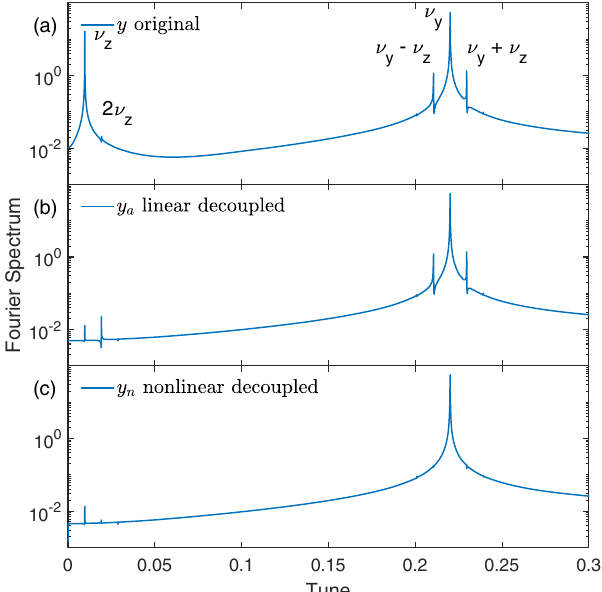
FIG. 2. Decoupling of the vertical turn-by-turn trajectory for a case with ν y ¼ 6 . 22 and ξ y ¼ 10 . The Fourier spectra for three coordinates, the original y (a), the linearly decoupled ¯ y a (b), and the nonlinearly decoupled coordinates y n (c), are shown. The resonance tune lines are labeled. The launching condition for tracking is y ¼ 10 μ m and δ ¼ 1 × 10 − 5 .